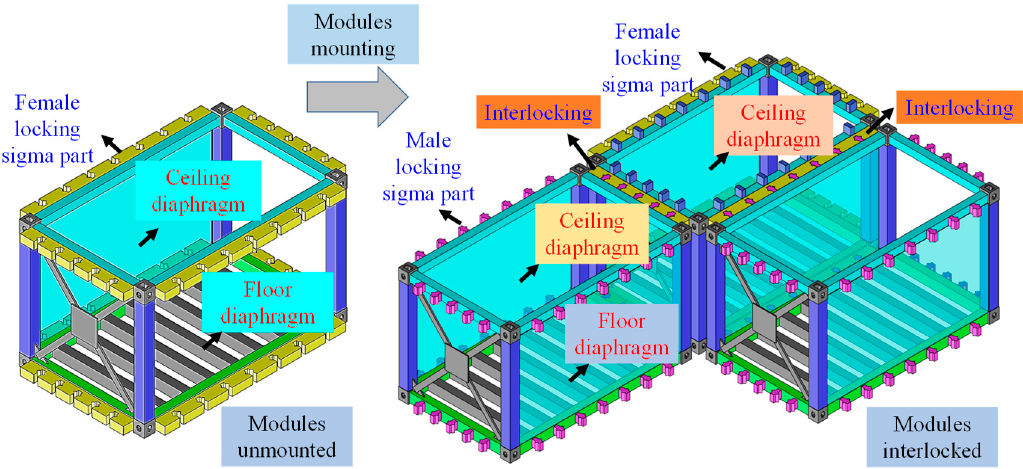
Figure 9. Self-locking automatic horizontal beam-to-beam IMC.